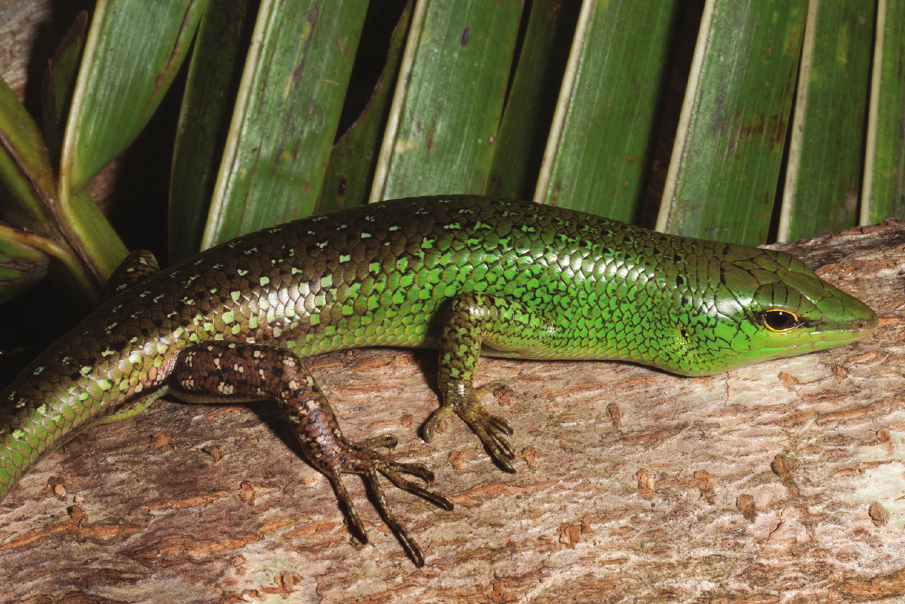
Figure 55. Lamprolepis smaragdina philippinica is common throughout coastal areas of northeast Mindanao . Photo: RMB (from the Municipality of Burauen, Leyte Island; specimen deposited at